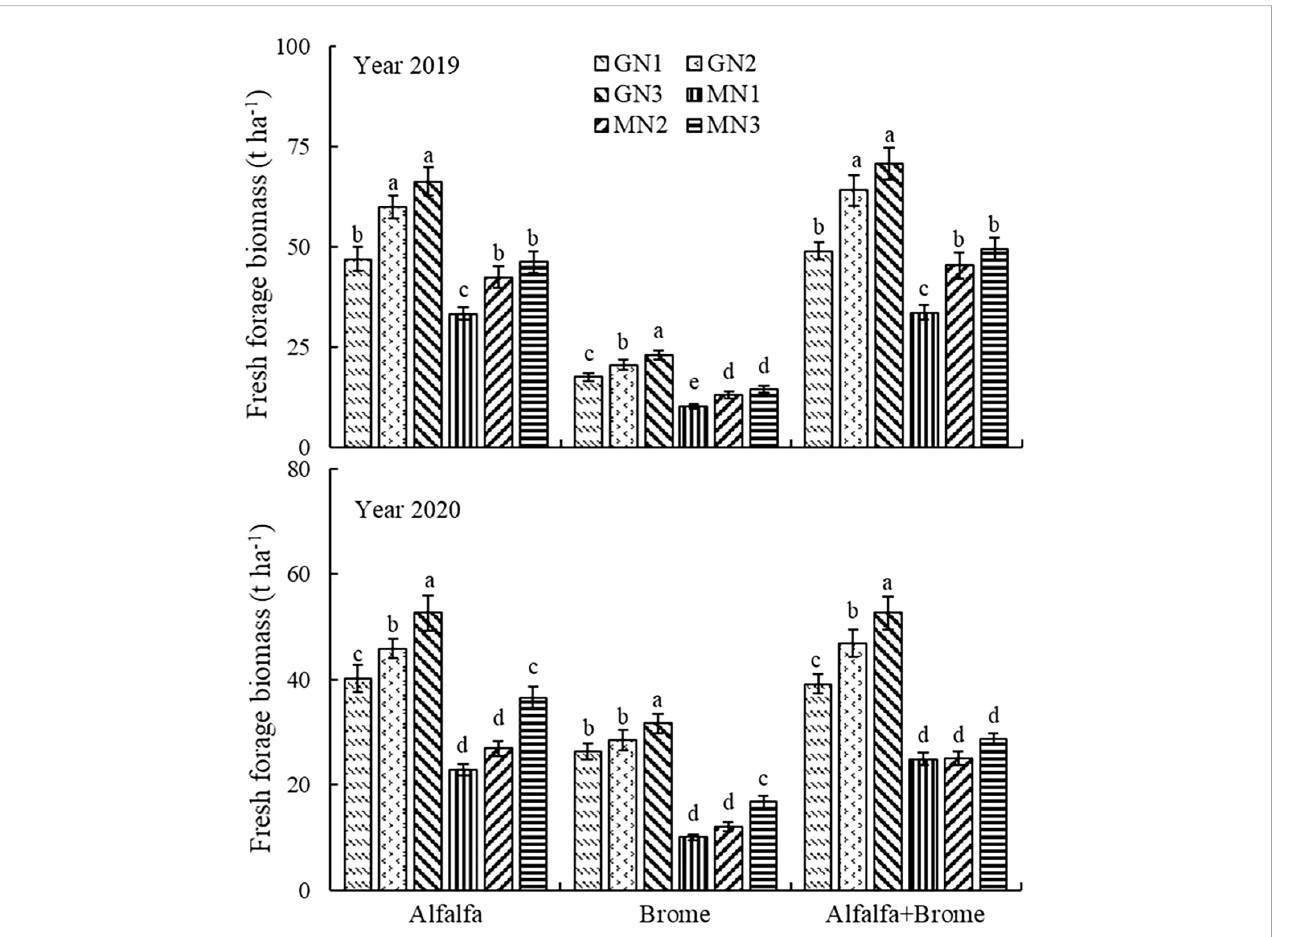
FIGURE 3 Fresh forage biomass of pasture under different treatments Note: The different lowercase letters indicate a signi fi cant difference among different treatment at P ≤ 0.05. GT denotes grassland type, MM denotes fi eld management measures, and GT×MM denotes the interaction between grassland type and fi eld management measures. The GN1, GN2, GN3, MN1, MN2, and MN3 treatments indicate no nitrogen application under grazing, 80 kg ha -1 nitrogen application under grazing, 160 kg ha -1 nitrogen applications under grazing, no nitrogen application under cutting, 80 kg ha -1 nitrogen application under cutting, and 160 kg ha -1 nitrogen application under cutting,